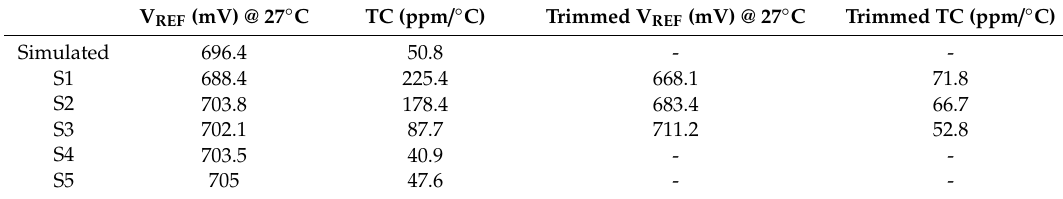
Figure 17. Measured V REF as a function of temperature for five chip samples (trimmed). Table 7. Measured V REF as a function of temperature.